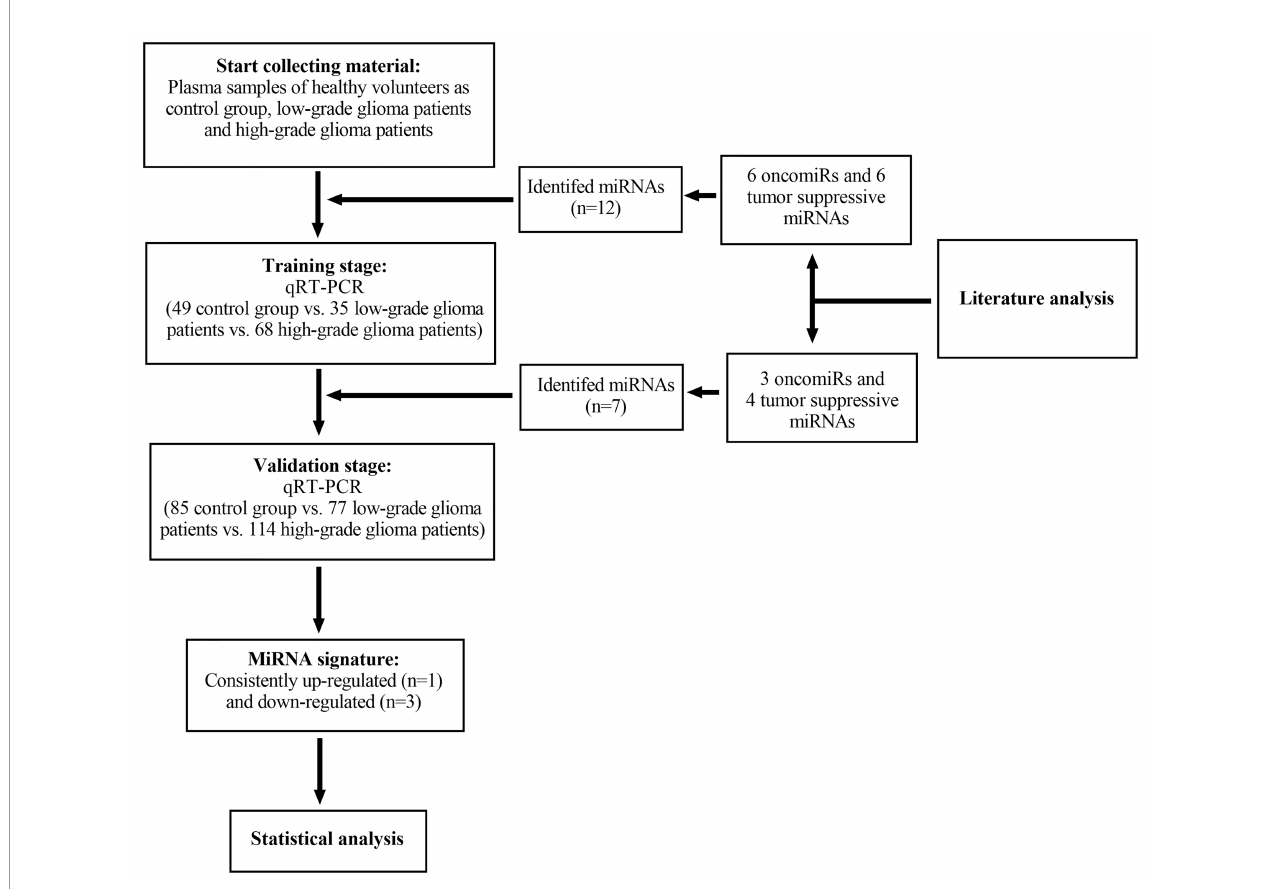
FIGURE 3 | Flow diagram illustrating the steps for microRNAs (miRNAs) selection, expression pro fi ling and differential expression analysis. qRT-PCR, quantitative reverse transcription polymerase chain reaction; miRNAs,